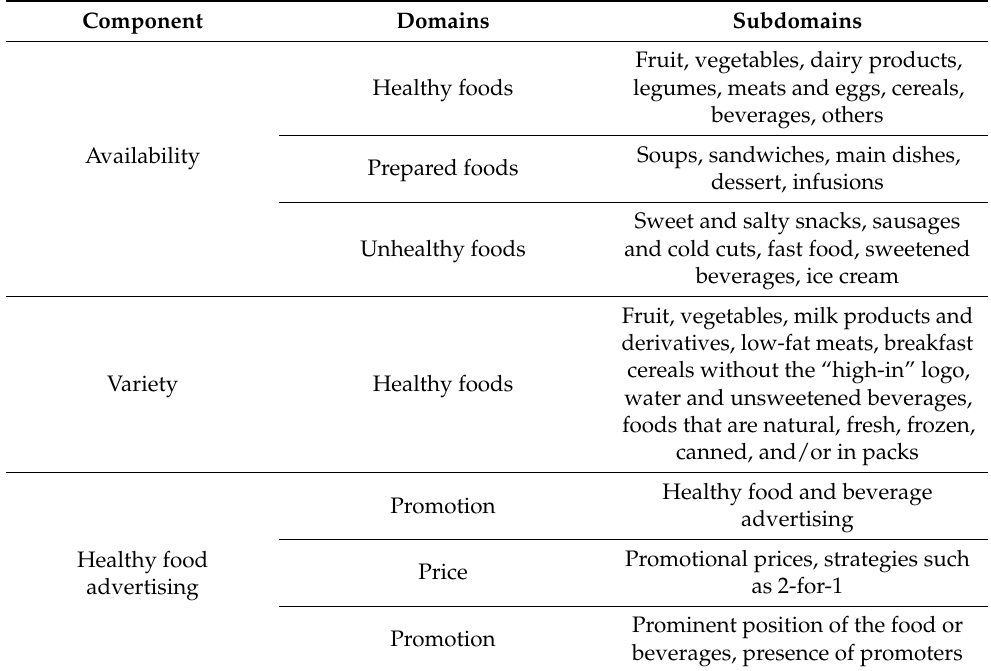
Table 1. General description of components, domains, and subdomains of the instruments to measure food environments in